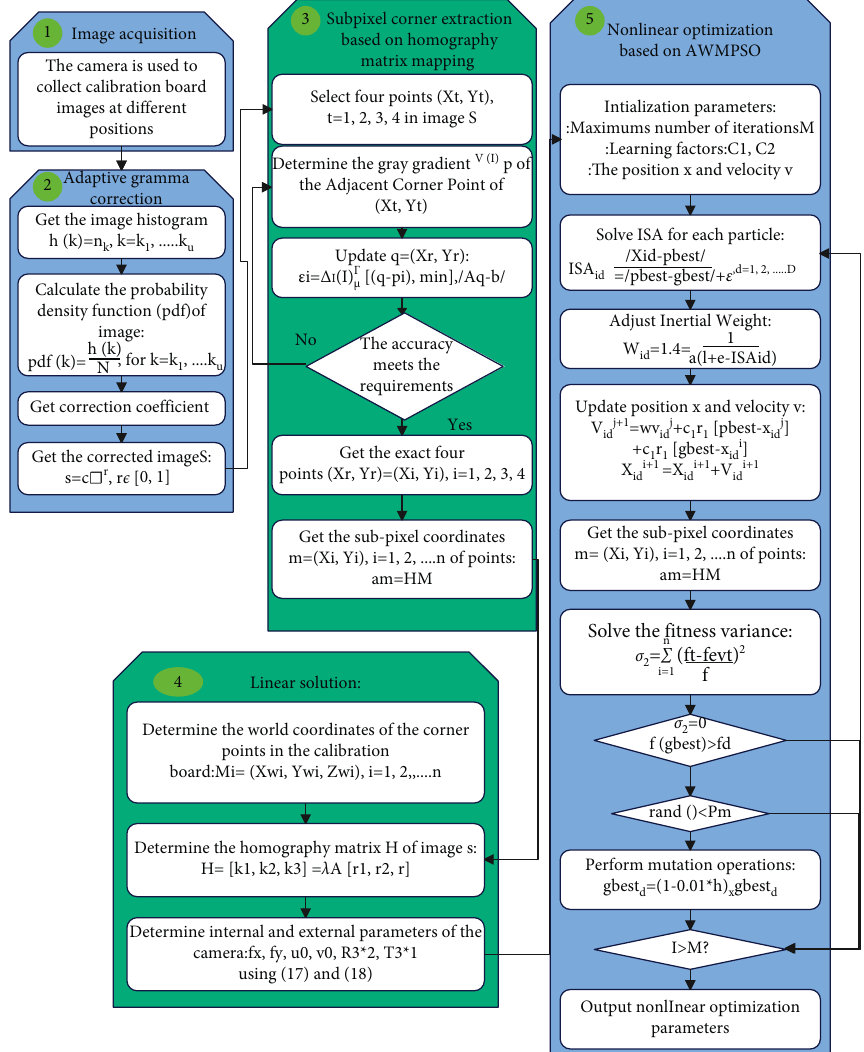
Figure 3: Overall flow chart of the improved calibration